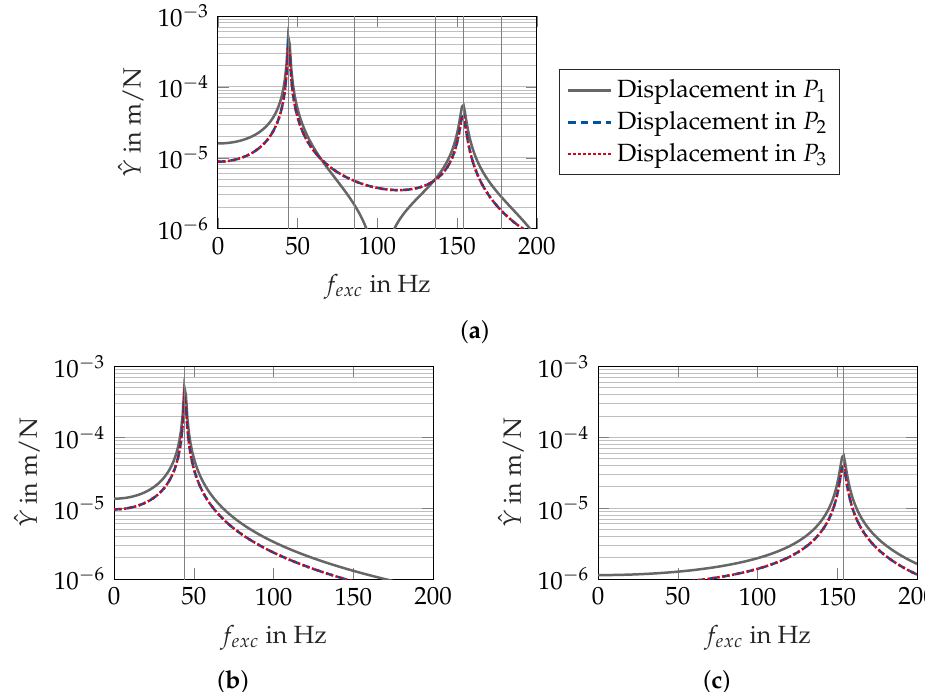
Figure 4. Magnitudes ˆ Y of the transfer mobility for force application in P 1 as a function of the excitation frequency f exc : ( a ) (Overall) transfer mobility; ( b ) Modal transfer mobility of mode 1; ( c ) Modal transfer mobility of mode 4.